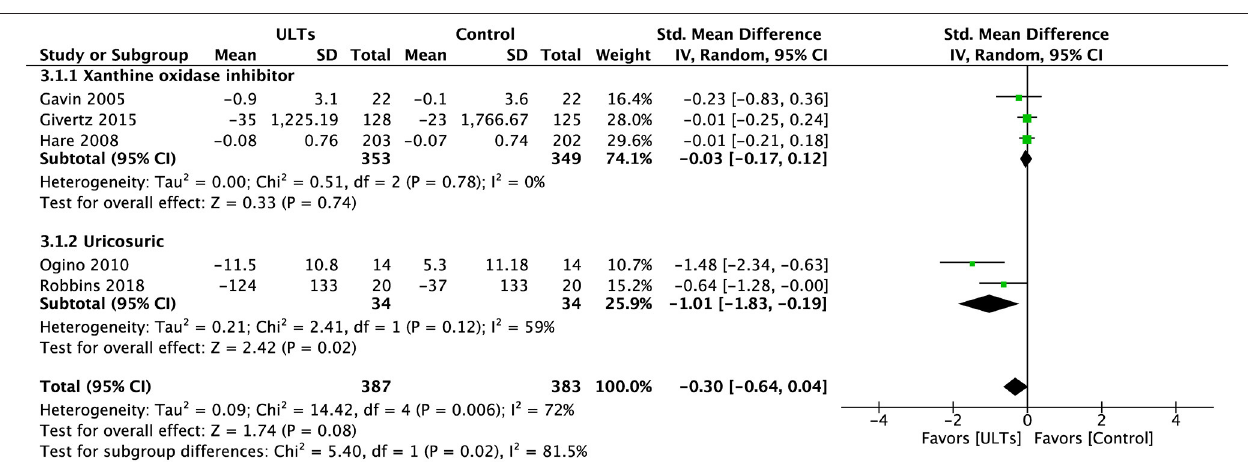
Frontiers in Cardiovascular Medicine |